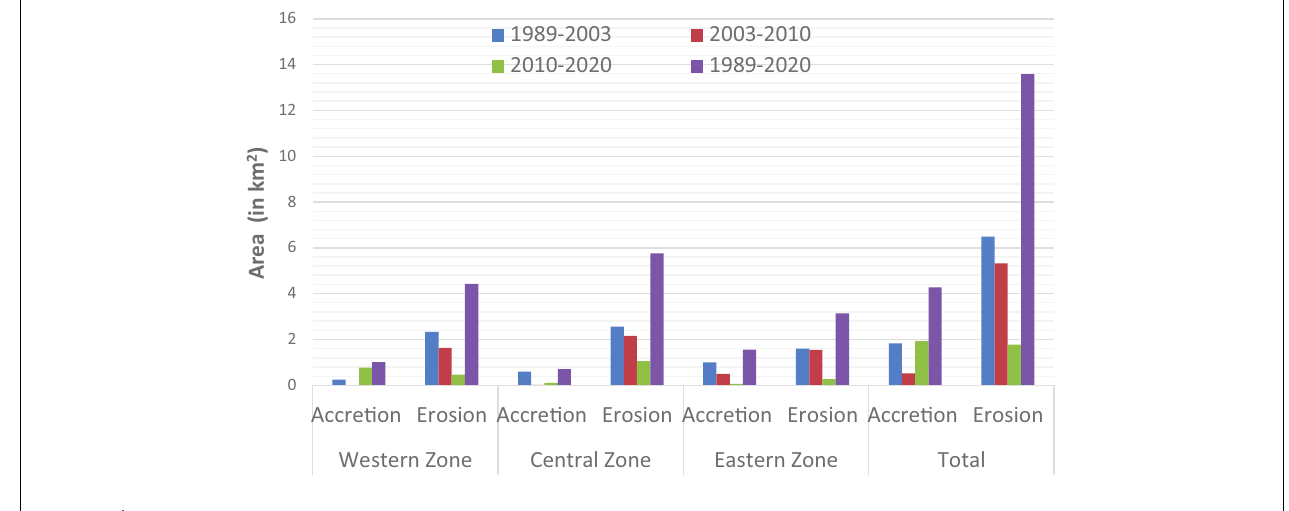
FIGURE 3 | Kuakata coastal land area changes by zone (from 1989 to 2020).